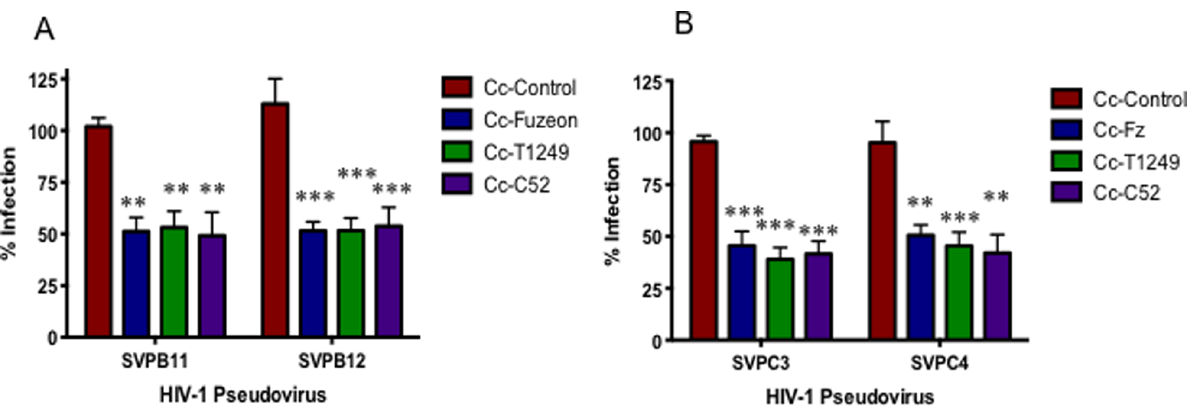
Figure 5. Fusion inhibitor viral blocking assay. Cc-Control, Cc-Fz, Cc-T1249 and Cc-C52 were incubated for 48 hours with TZM-bl cells and 200TCID50 clade B (SVPB11, SVPB12) or clade C (SVPC3, SVPC4) HIV-1 pseudovirus. HIV-1 infection rate was measured indirectly using a mammalian b -galactosidase assay. Infection rate is given as a percentage and normalized to wells containing virus + TZM-bl cells with the background for uninfected TZM-bl cells substracted out. The assay was set-up in quadruplicate and repeated a minimum of 3 times. p values represent the difference between control and each construct individually. *p , 0.01, **p , 0.001.